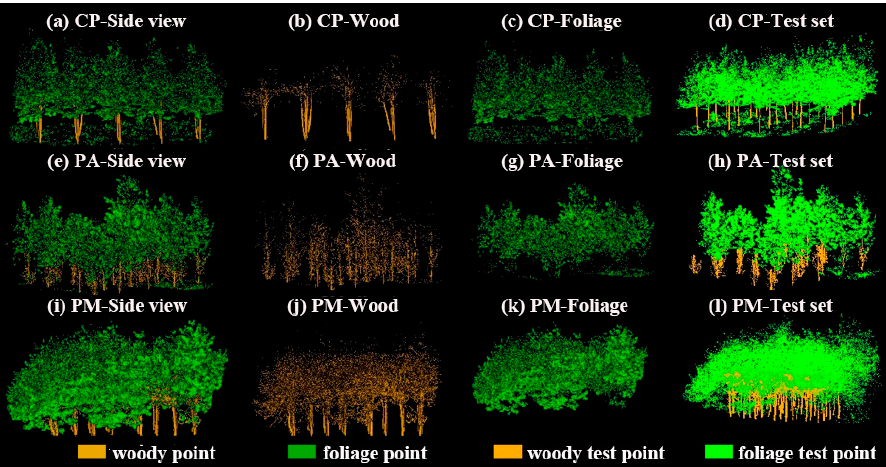
Figure 6. The classification results of foliage and woody points by using the FWCNN model. The subfigures ( a ), ( e ), and ( i ) show the side views of classification results at the plot level. The subfigures ( b ), ( f ), and ( j ) show the woody points in the classification results. The subfigures ( c ), ( g ), and ( k ) show the foliage points in the classification results. And the subfigures ( d ), ( h ), and ( l ) show the test point sets selected from three TLS datasets to evaluate the classification accuracy. Table 2. Comparing the classification accuracy of using six types of classifiers (FWCNN, GMM, RF, SVM, LeWoS, and LWCLF) to separate woody and foliage points from (original and LRI-corrected) TLS data. Within these classifiers, the LeWoS and LWCLF models only used the geometric-based features to classify woody and foliage components from TLS data. The RT means the threshold to reclassify the pointwise classification scores analyzed by the FWCNN model. The data in the time column show the time consumption of running four types of classifiers apart from the feature extraction process. We did not list the time cost of two geometric-based models owing to their feature extraction methods were different from the other four classifiers. The F-T and W-T mean the number of foliage and woody points that were correctly classified within the test sets. The OA means the overall classification accuracy. The FPA and WPA mean the producer’s accuracy of foliage and woody points in the classification results, respectively.